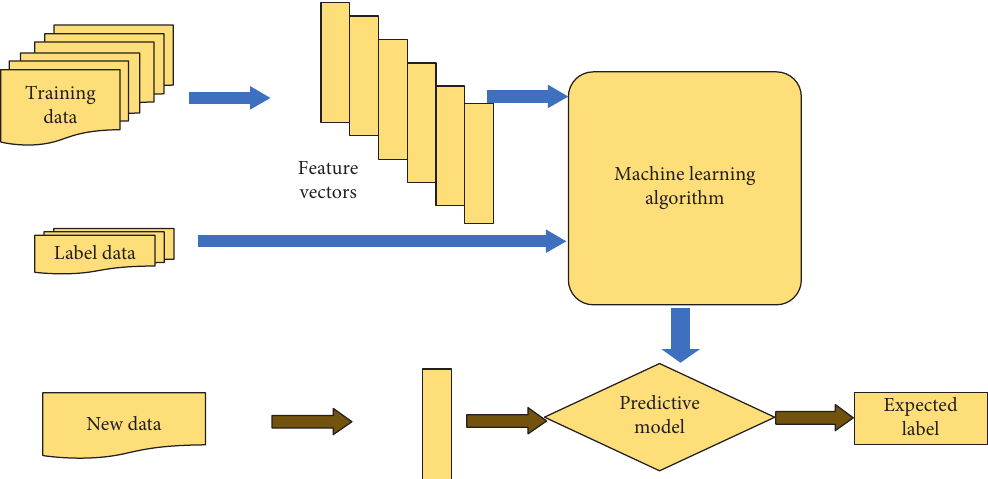
Figure 1: Standard steps in supervised learning for classification.